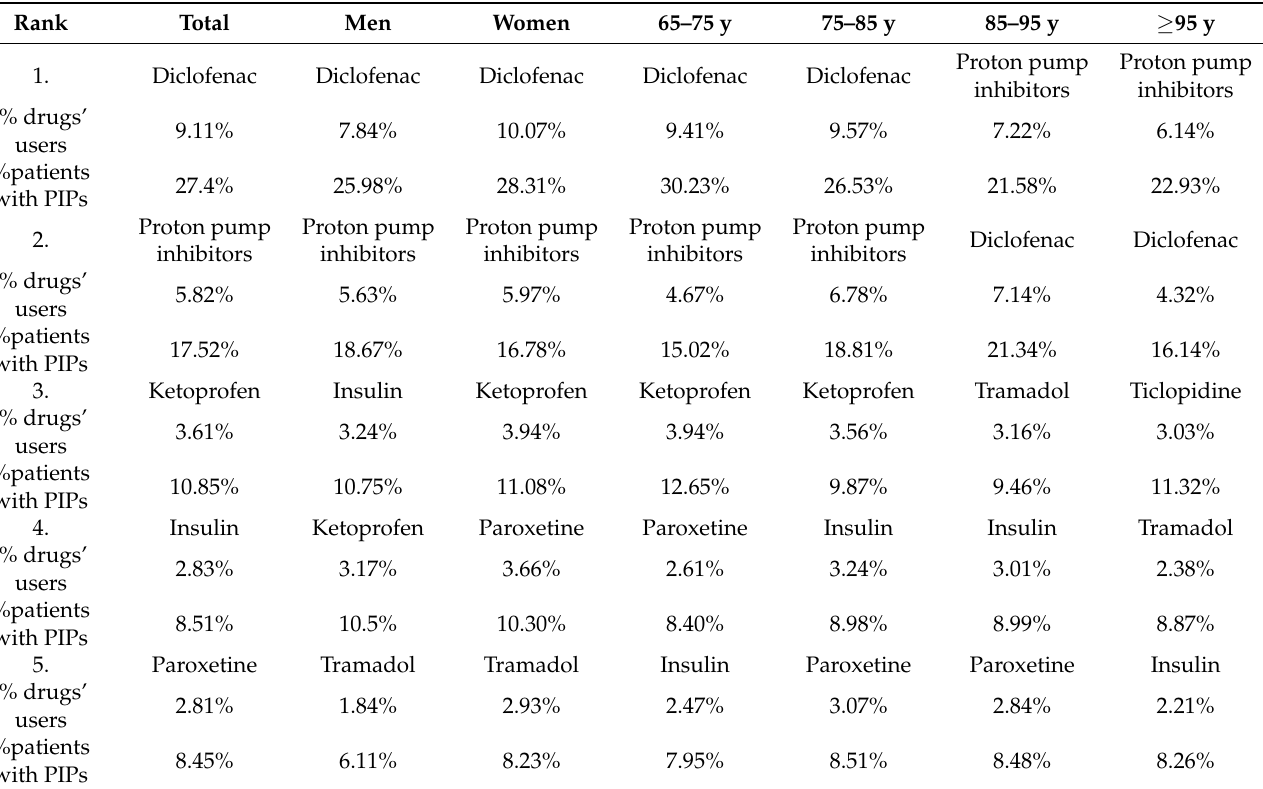
Figure 2. Prevalence of exposure to at least one potentially inappropriate prescription among the drugs’ users by the sex of outpatients older than 65 years in Piedmont in the period 2012–2018. Table 3. Characteristics of outpatients older than 65 years exposed to at least one potentially inappro- priate prescription in Piedmont in the